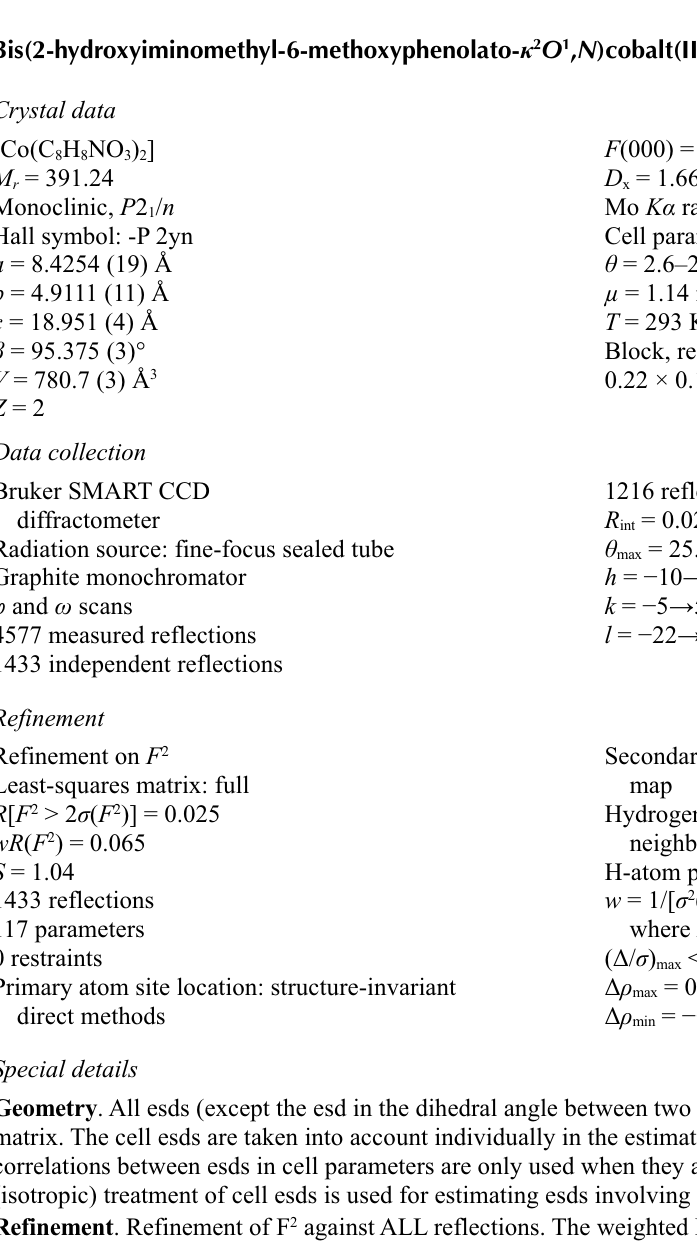
Figure 2 Packing diagram viewed down the b axis. Dasehd lines denote C—H···O contacts. Bis(2-hydroxyiminomethyl-6-methoxyphenolato- κ 2 O 1 , N